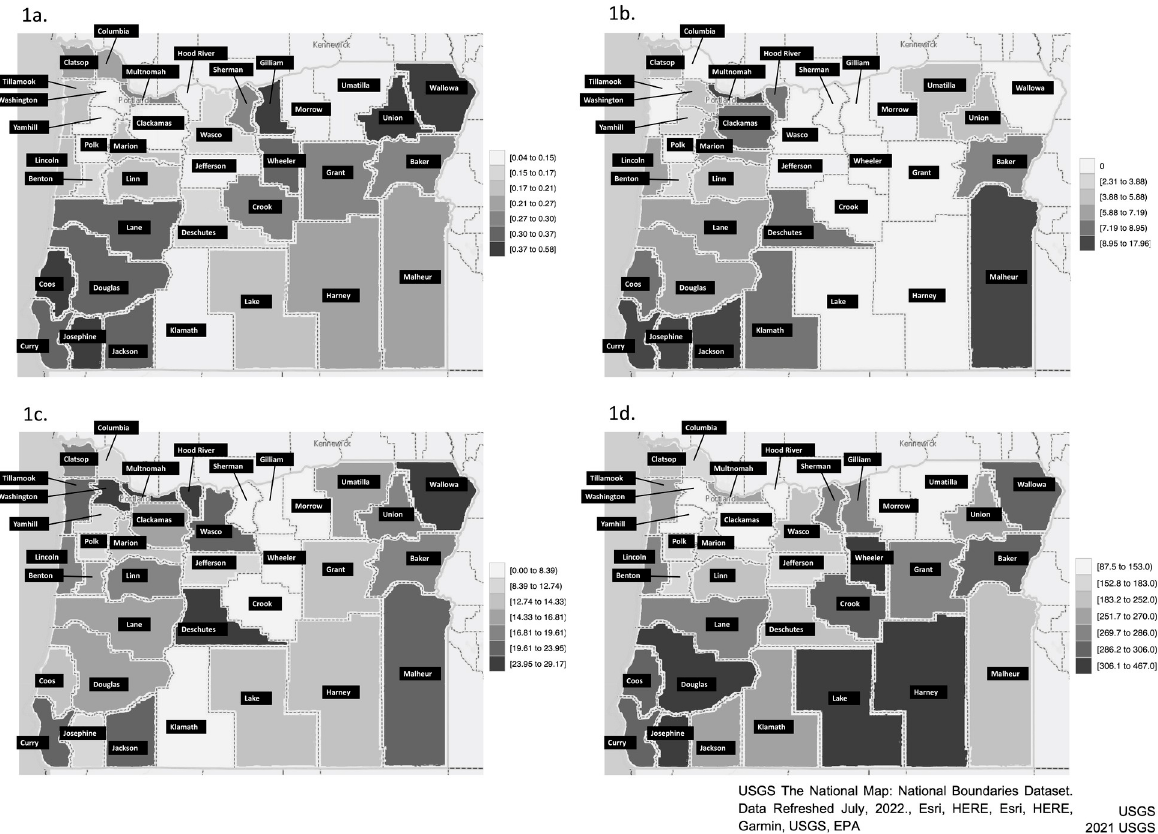
Fig 1. a . Prevalence of registered individuals with blindness per county in Oregon. b . Number of ophthalmologists in each Oregon county per 100,000 persons (year 2015). Counties with higher densities of ophthalmologists registered more people with blindness from any cause (OR 6.5 for blindness with one more ophthalmologist, p = .003, in a multivariable model using county data including median household income and race/ ethnicity). c . Number of optometrists in each Oregon county per 100,000 persons (year 2015). The density of optometrists was not associated with blindness (p = .889) in a multivariable model using county data including median household income and race/ethnicity. d . Multivariable model for the odds of blindness per 10,000 persons by county (year 2015). Multivariable model using county data (median household income and race/ ethnicity) in addition to density of ophthalmologists to predict the odds of blindness per 100,000 persons by county.